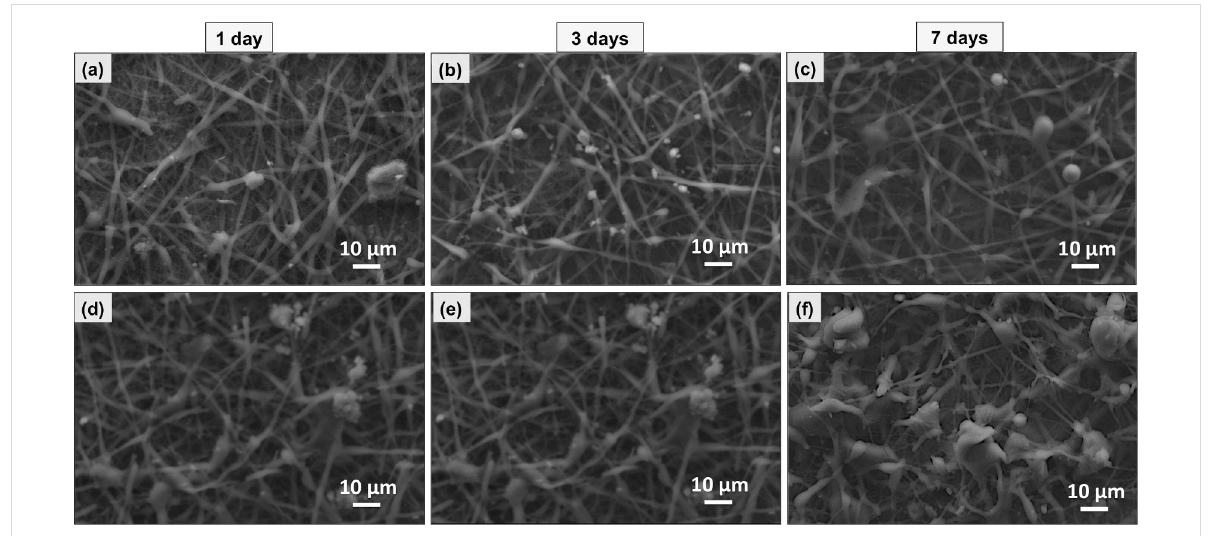
Figure 5: SEM micrographs of the (a–c) untreated PCL electrospun scaffolds for 1,3 and 7 days of direct contact with cells and (d–f) and of the O 2 -plasma-modified scaffolds, at the predetermined time